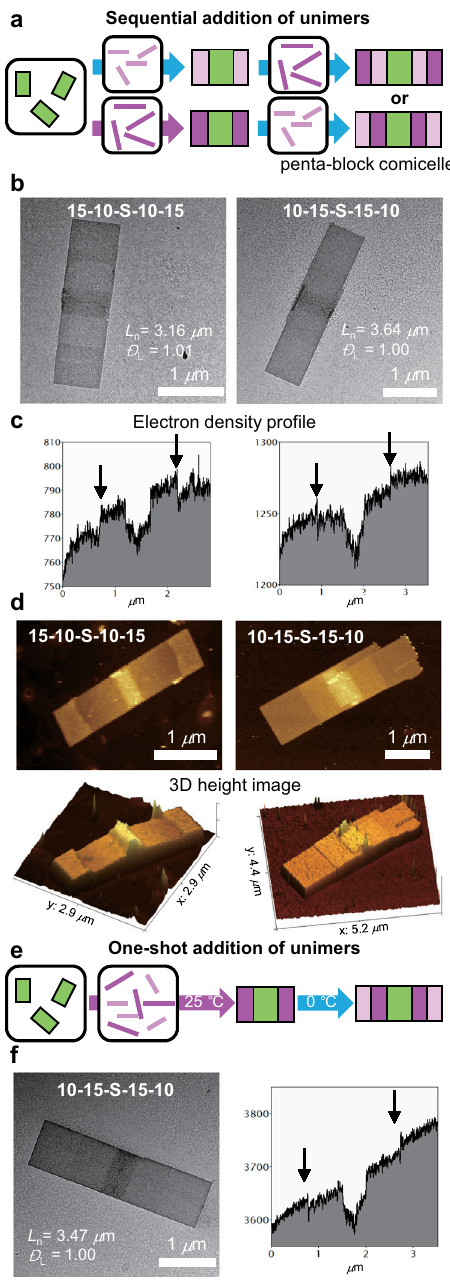
Fig. 5 Successful formation of symmetric penta-BCMs. a Schemes for the preparation of complex 2D BCMs by sequential addition of two unimers (P2 10 and P2 15 ). By changing the order of the unimer addition, two types of symmetric penta-BCMs were obtained. The 2D nanosheets of longer P2 15 unimers are shown in dark pink, and those of P2 10 unimers are shown in light pink. b TEM images, c electron density pro fi les, and d 2D, and 3D height AFM images of the penta-BCMs showing clear distinctions of the two types of penta- BCMs prepared by the sequential addition. e Scheme for the preparation of one 2D BCM by one-shot addition of two unimers. f TEM image and electron density pro fi le of the penta-BCM obtained by one-shot living CDSA. Numbers in the images indicate the average length ( L n ) and dispersity ( Đ L